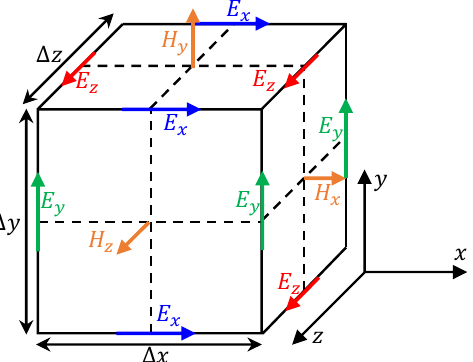
Figure 2. Yee grid of FDTD algorithm, E and H are electric field and magnetic field components, respectively. This kind of grid is used to discretize both continuous space and time; therefore, the propagation of electromagnetic waves in the medium can follow Maxwell ʹ s law.